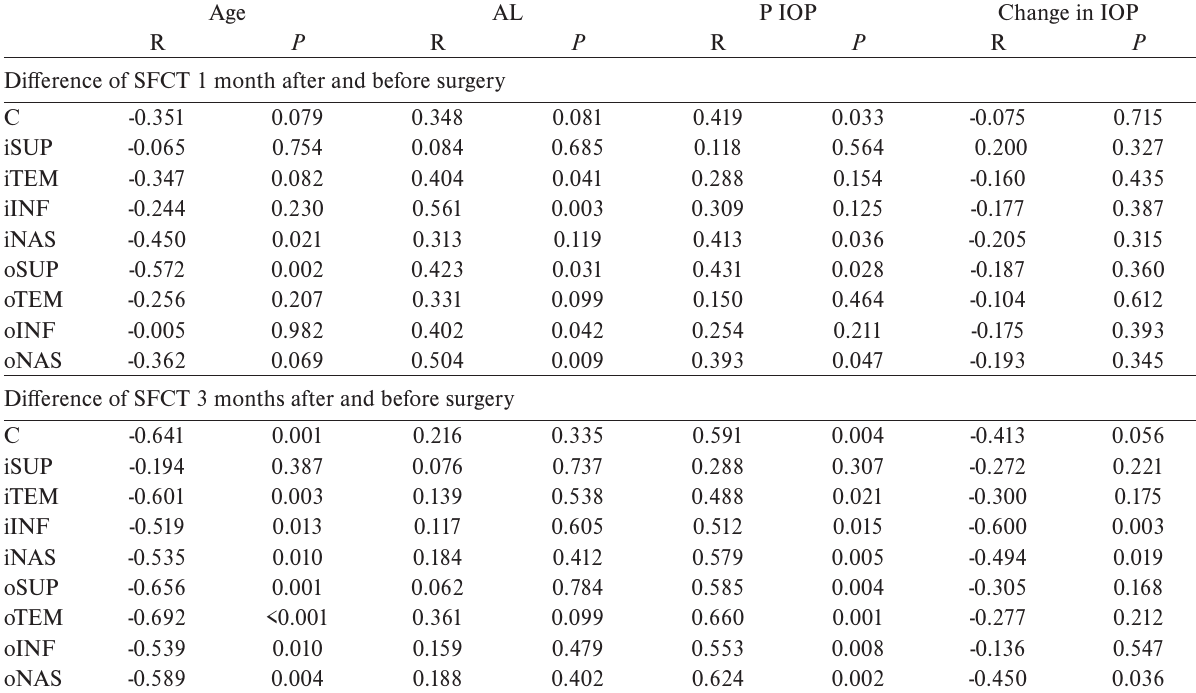
Table 3. Correlation between the difference of SFCT M1/M3 and P and various factors (correlation coefficient; significance